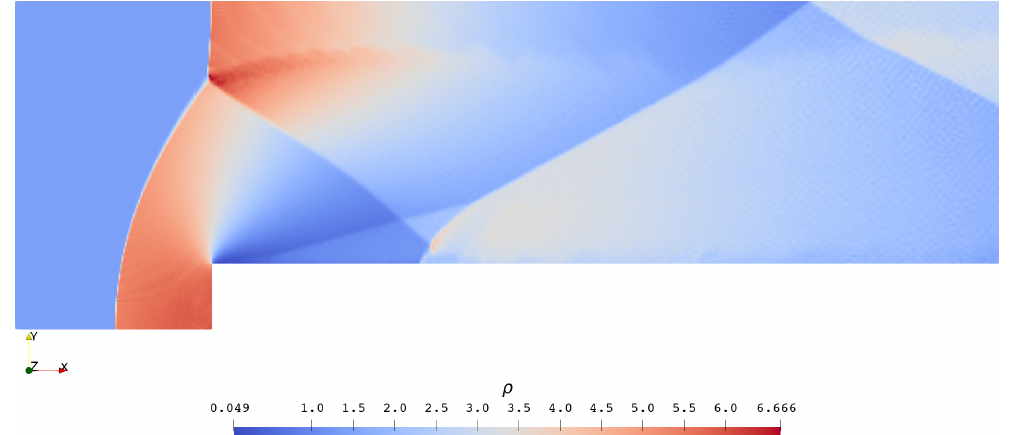
Figure 19. Third-order solution of Problem 4 at t = 4.0 on an h = 1/200